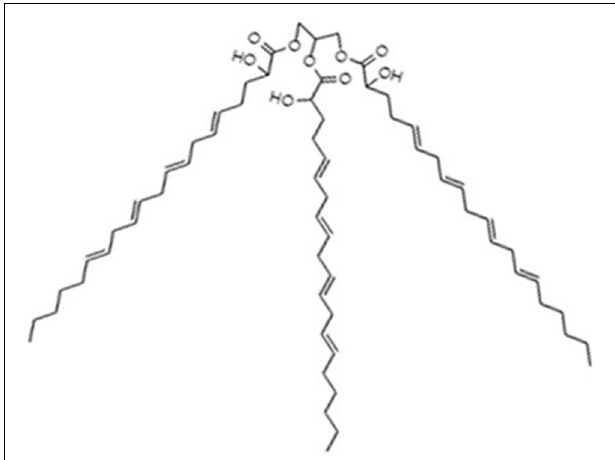
FIGURE 1 | Molecular structure of TGM4. This compound is a triacylglycerol mimetic containing three 2-hydroxyarachidonyl moieties.